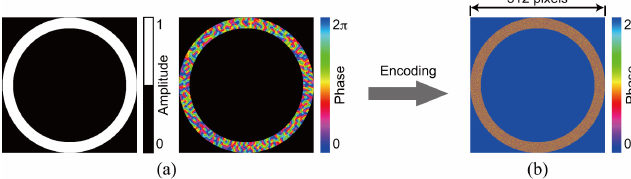
Figure 4. Reference beam for recording data page 1. ( a ) complex amplitude distribution and ( b ) phase hologram.